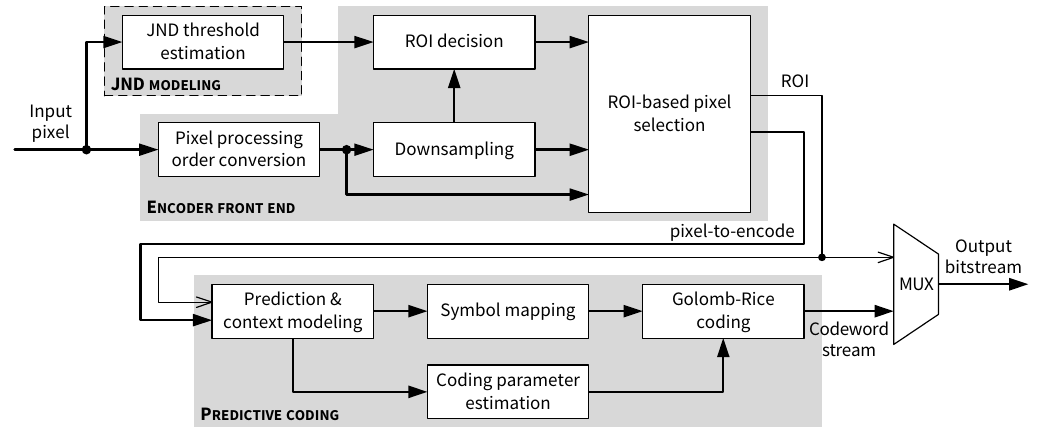
Figure 17. Overview of the proposed JND-based perceptual encoder